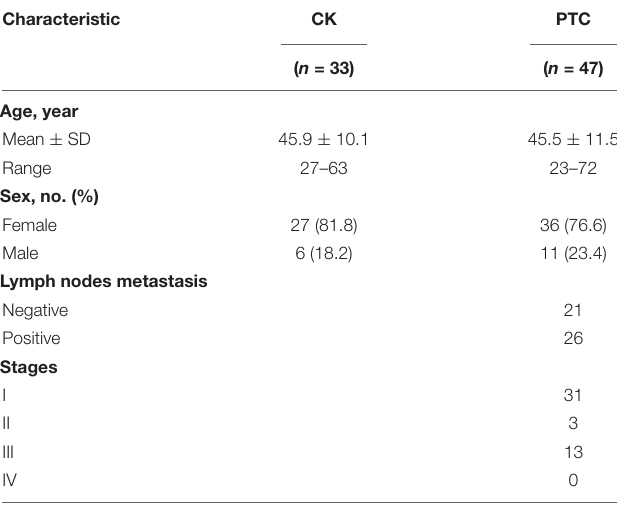
TABLE 1 | Baseline characteristics of the